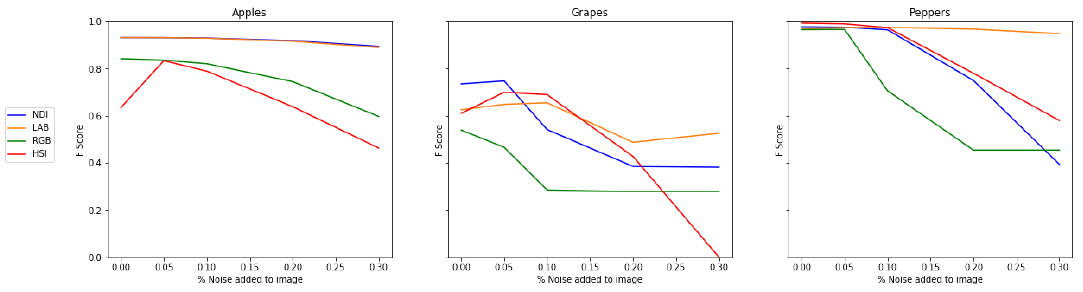
Figure 15. Sensitivity analysis: adding noise to the